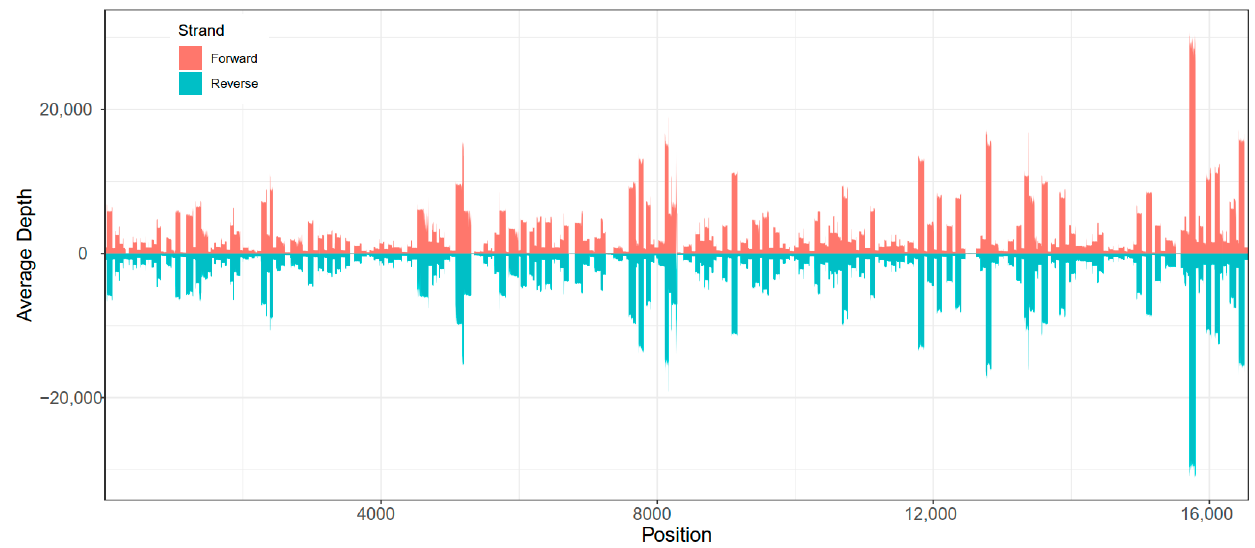
Figure 2. The average read depths of both forward and reverse strands at each nucleotide position in the mtGenome. Data from the 4 controls were not included, resulting in a total of 60 calculated datasets.